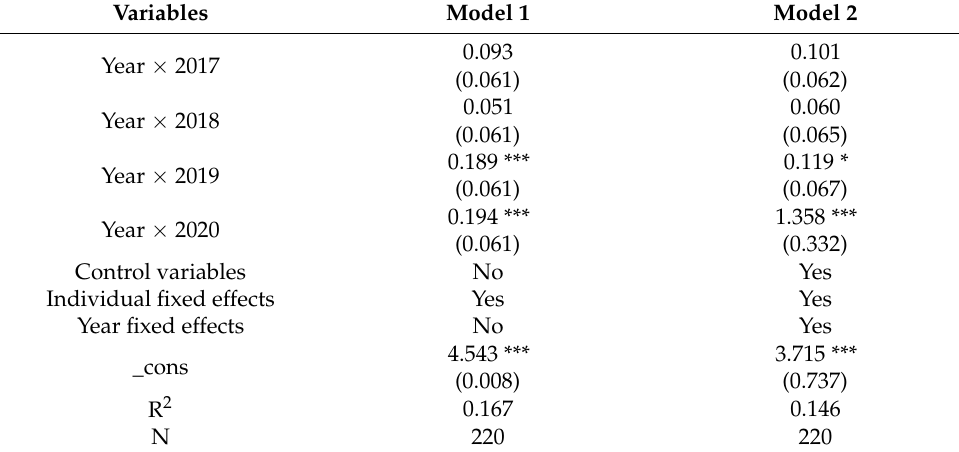
Table 5. Dynamic effects of